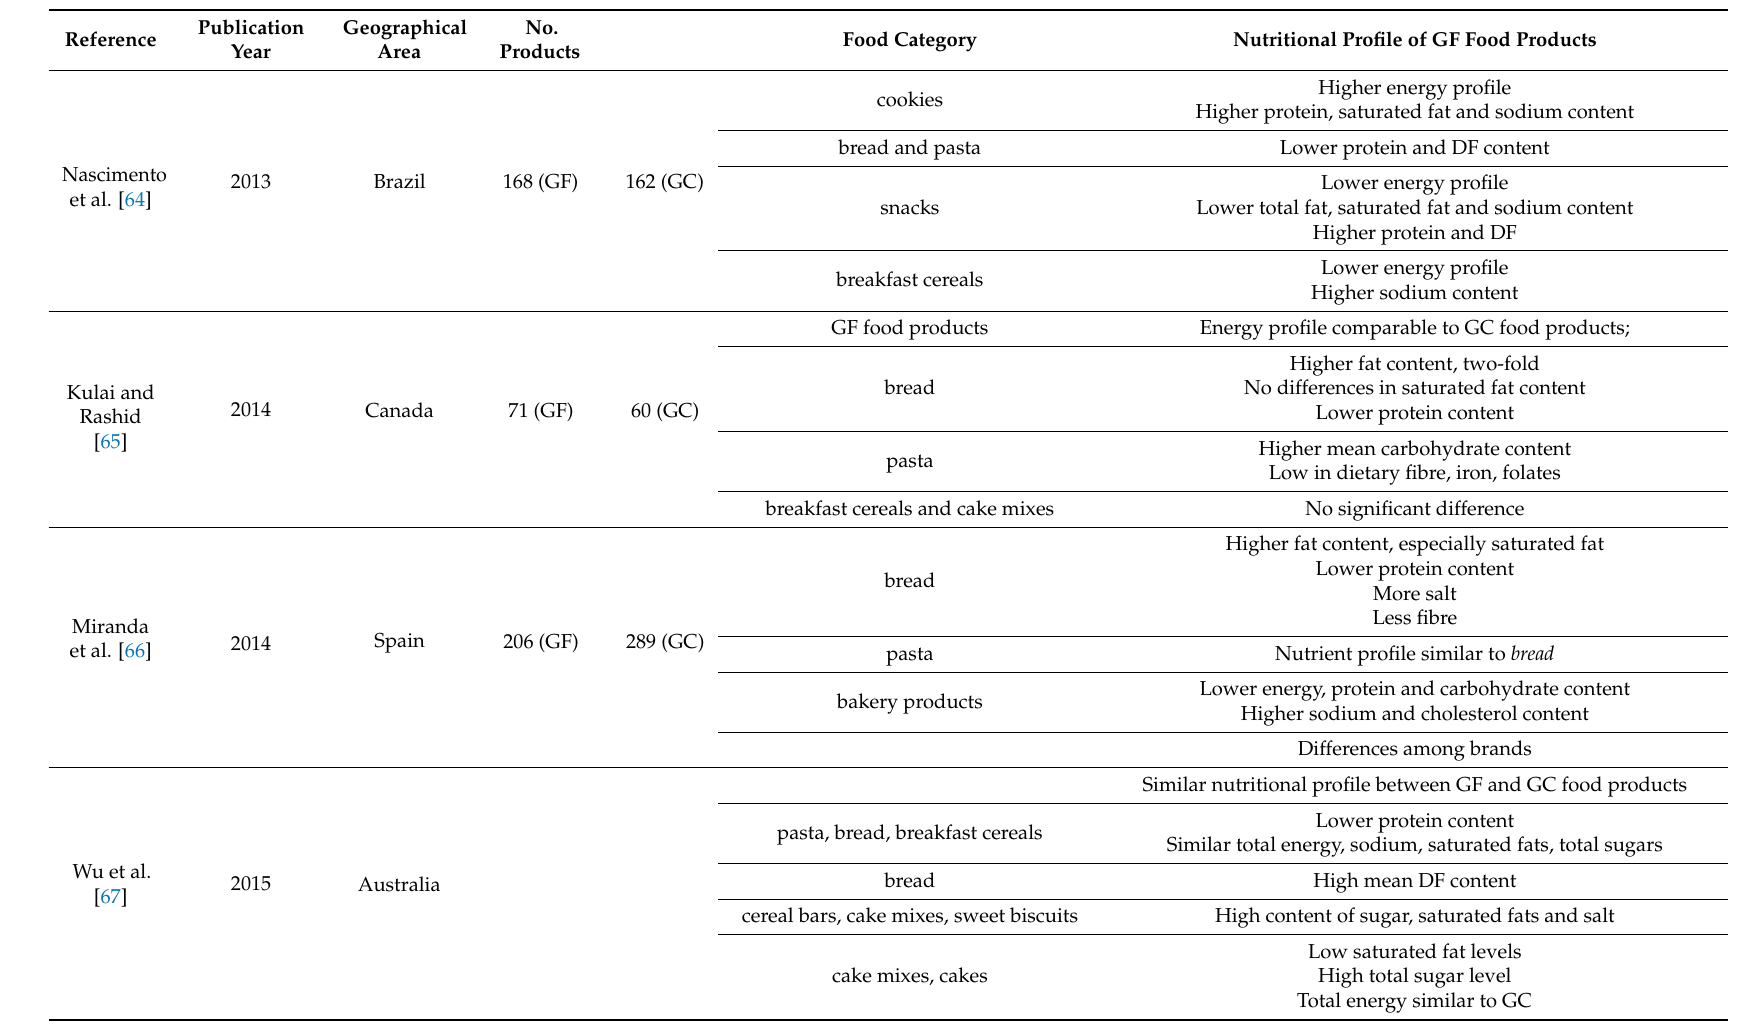
Table 2. Surveys on the nutritional profile of GF food products available on the worldwide